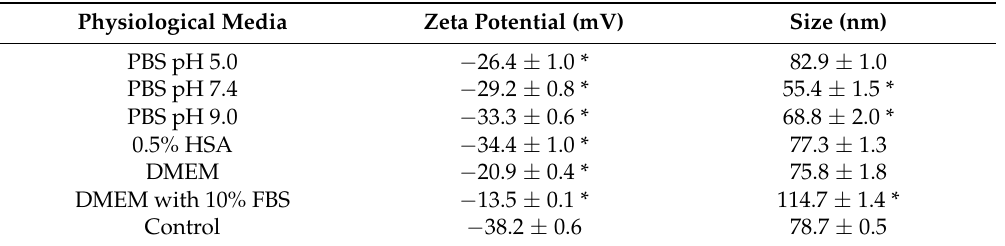
Table 1. Zeta potential values and hydrodynamic sizes of gold nanoparticles after 24 h of incubation